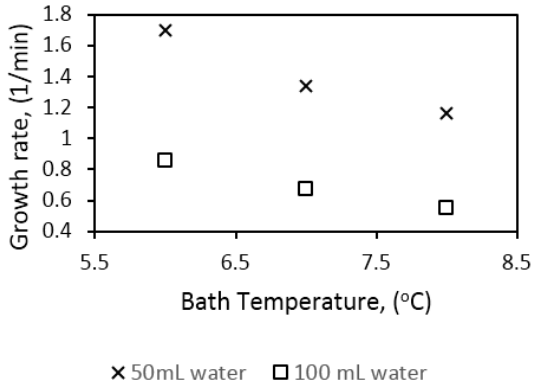
Figure 13. Effect of water content on hydrate growth (700 rpm).